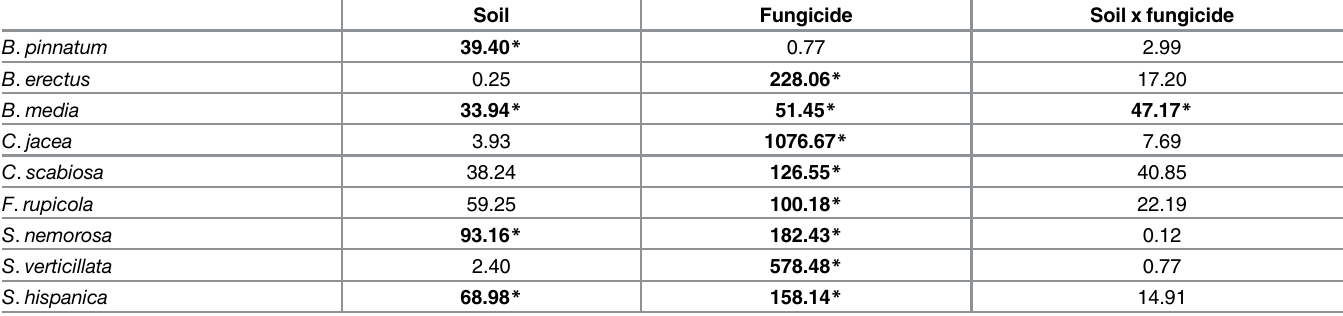
Table 3. The effect of soil type, fungicide and their interaction on root colonization of plants in the experiment. The values shown represent devi- ance. Significant values (p (cid:2) 0.05) are in bold and marked by * . A full table including p-values and df-error is given in S5 Table and S6 Table. Soil Fungicide Soil x